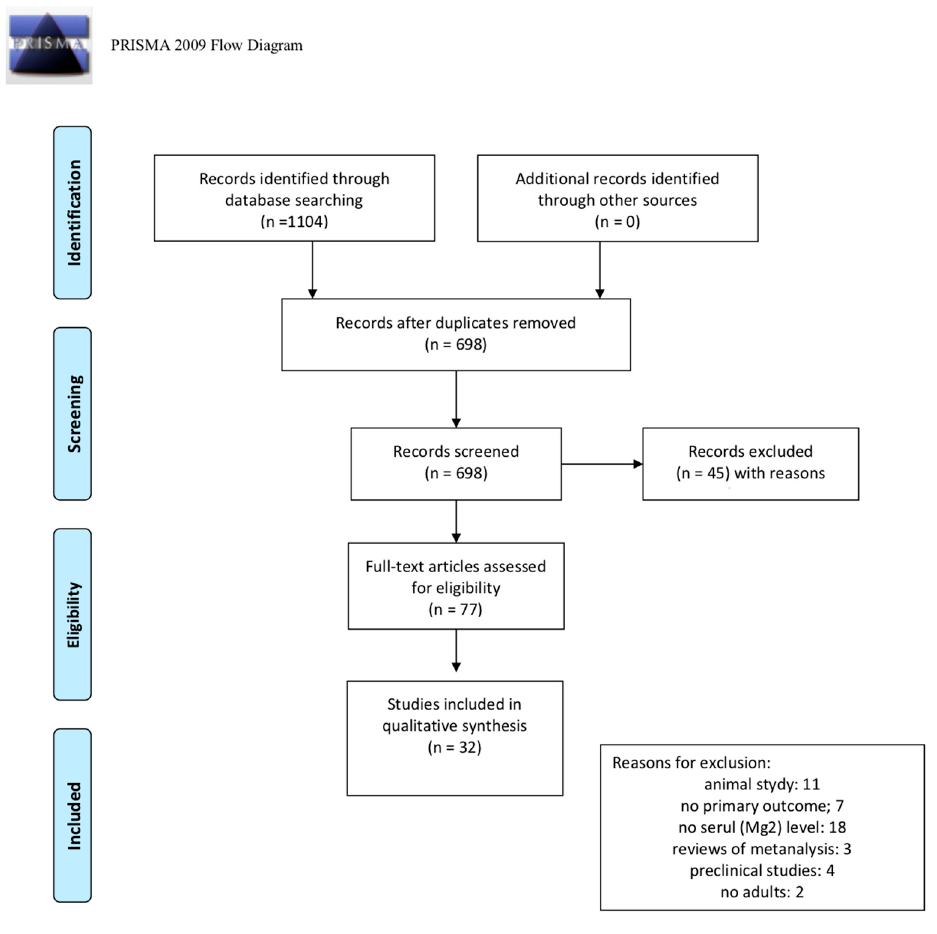
Figure 1. PRISMA (2009) flow diagram